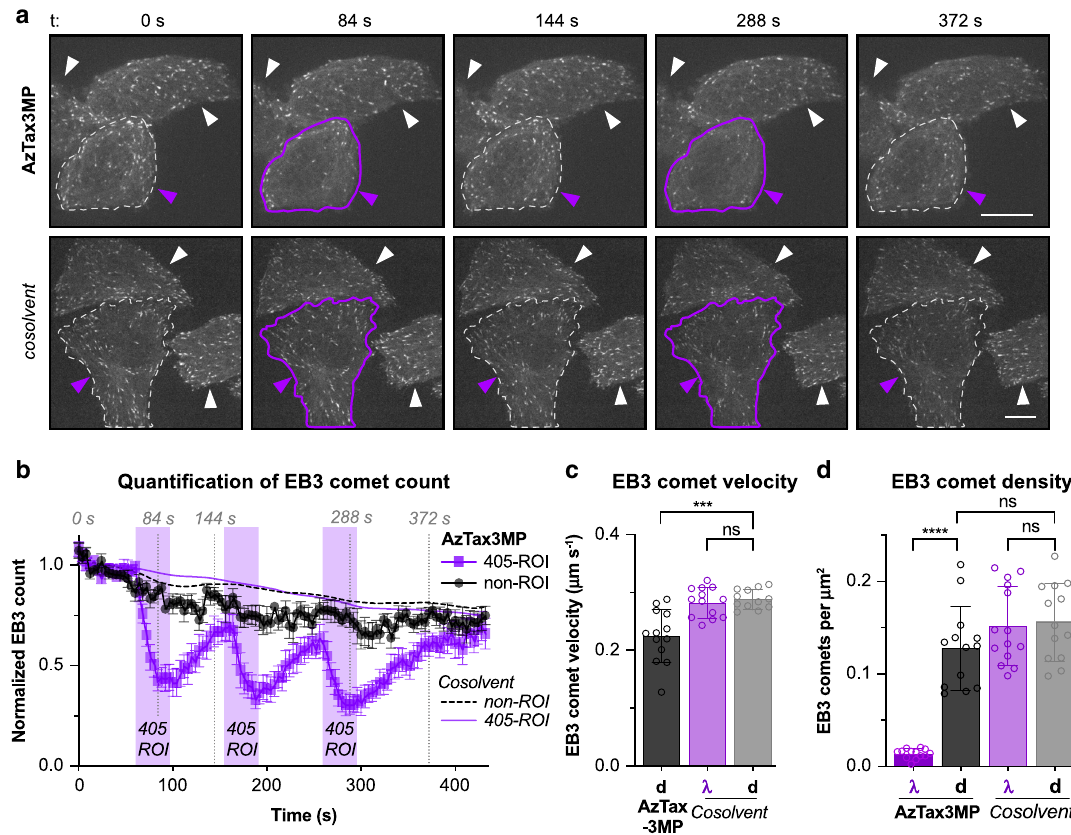
Fig. 5 AzTax photoswitching allows cell-precise, temporally reversible inhibition of MT polymerisation dynamics. Data related to Supplementary Movies 1 and 2. HeLa cells transfected with EB3-tdTomato treated with 1% DMSO cosolvent with or without 1 µ M AzTax3MP . a, b Target cells (violet arrowheads) were selectively illuminated with 405 nm in bursts, and EB3 tracking in de fi ned regions of interest (ROIs) performed. a Target ROIs in frames acquired immediately after 405 nm illumination are outlined in violet, target ROIs in t 0 and post-recovery frames (ca. 80 s after 405 nm illumination periods) are outlined in dotted white; nontarget cells are indicated with white arrowheads; scale bars indicate 10 µ m. b Quanti fi cation of EB3 comet